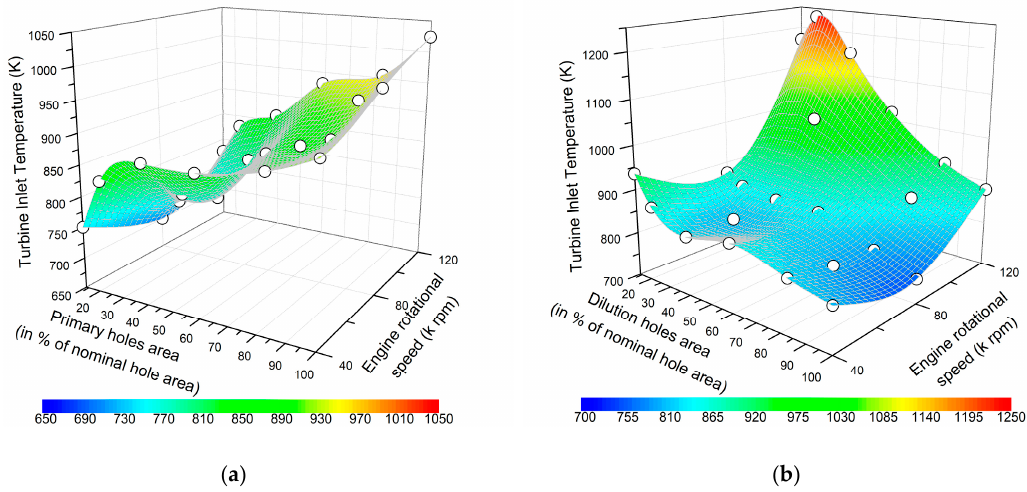
Figure 6. Impact of the combustion chamber air holes variable geometry on turbine inlet temperature: ( a ) primary zone air holes; ( b ) dilution zone air holes.